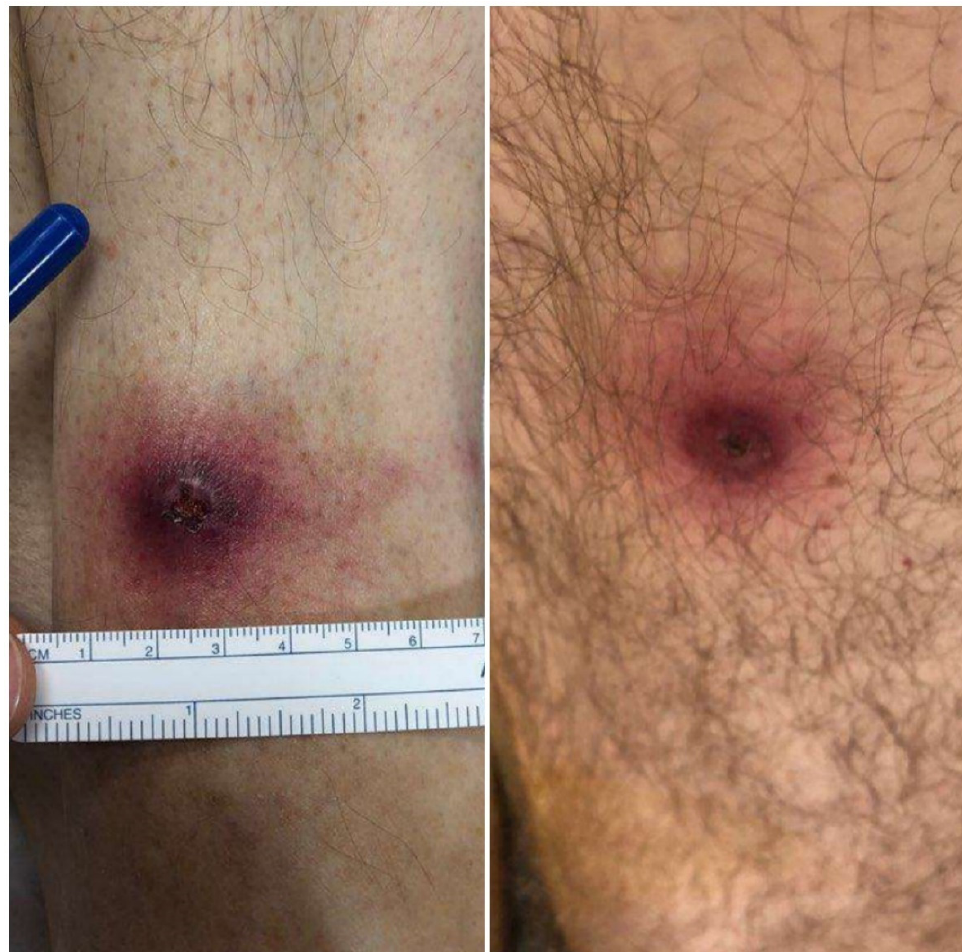
Figure 1. Ulcerative lesions with a central eschar on the patient’s left distal tibia ( left ) and left posterior thigh ( right ).